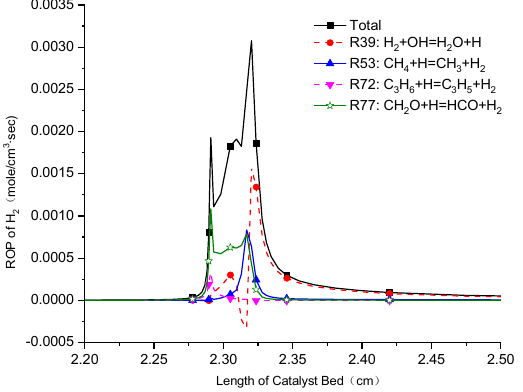
Catalysts 2019 , 9 , x FOR PEER REVIEW Figure 7. Sensitivity analysis of H 2 concentration in the preferred reaction conditions.